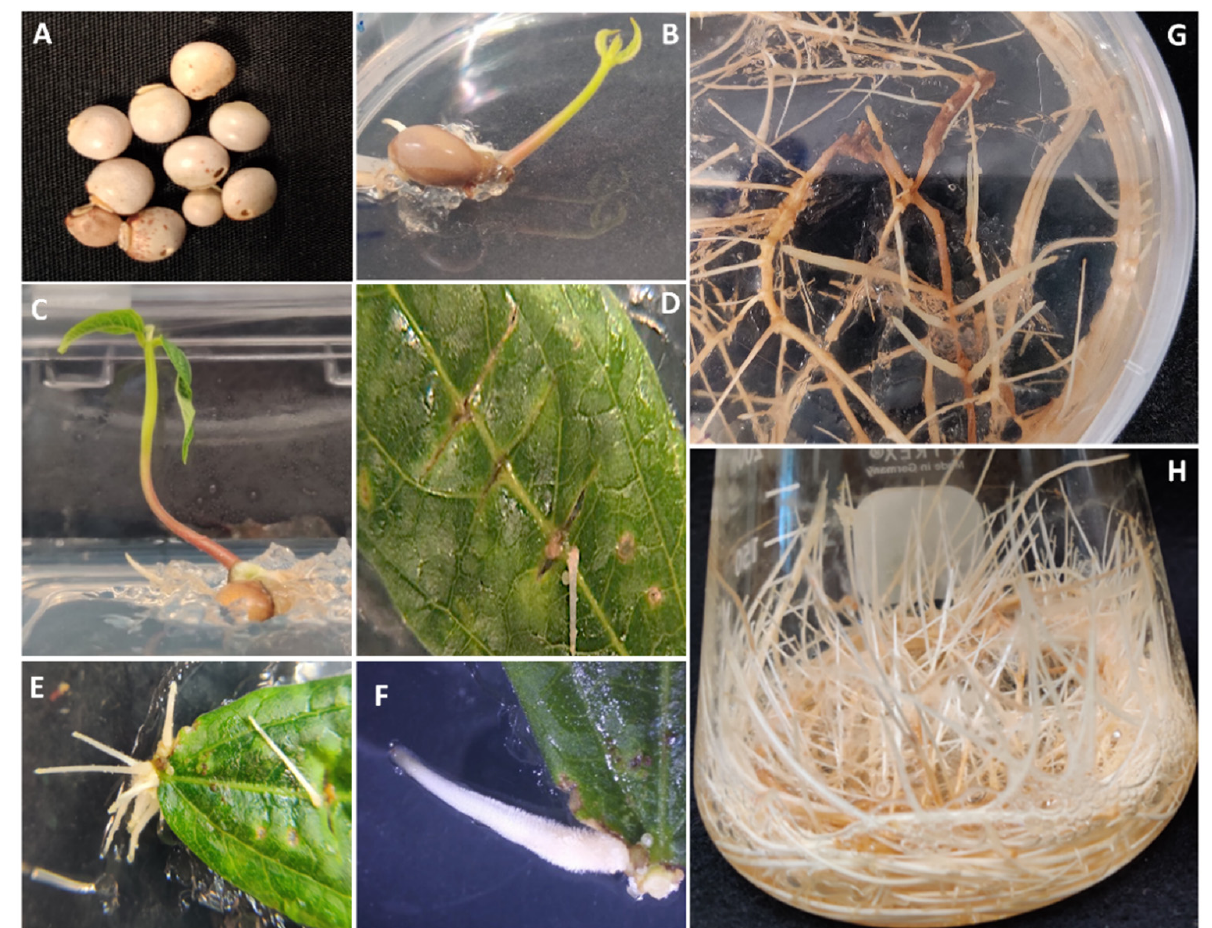
Figure 1. Germination and establishment of hairy root cultures of pigeon pea. ( A ): Seeds of pigeon pea; ( B ): ten-day-old seedling; ( C ): three-week-old seedling grown in vitro; ( D – F ): hairy root development from leaf infected with Agrobacterium rhizogenes ; ( F ): branching of hairy roots after excision from the leaf; ( G ): phenotype of the hairy root line G4 on semi-solid medium; and ( H ): phenotype hairy root line G4 in the liquid medium after 15 days in culture.